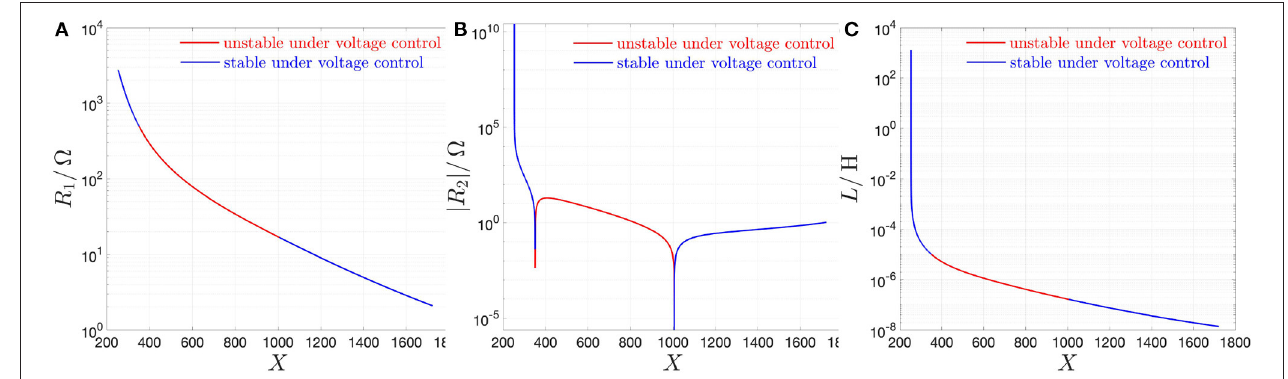
FIGURE 11 | Loci of the resistance R 1 (A) , of the modulus of the resistance R 2 (B) , and of the inductance L (C) in the small-signal equivalent circuit model of the NbO threshold switch from NaMLab as a function of the memristor state operating point X . In each plot, the red (blue) color is assigned to each branch corresponding to G − 1 of the threshold switch, unstable (stable) state operating points under voltage control. As expected, given that it represents the instantaneous resistance R = which is a passive device, R 1 is positive at all operating points. R 2 is found to have a negative sign throughout the red-colored branch, i.e., along the whole NDR region R 2 is found to be positive at all operating points). Finally, the sign of L is positive irrespective of X . of the memristor DC I m – V m characteristic (note, however, that R 1 +